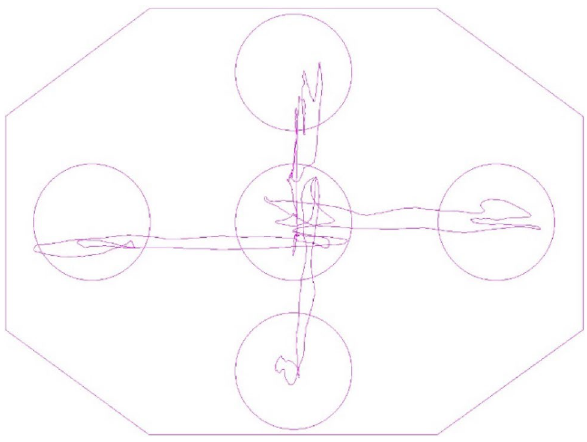
Figure 1. Diagram of the targets deployment with an example of the COP path trace (a screenshot from the software used for the